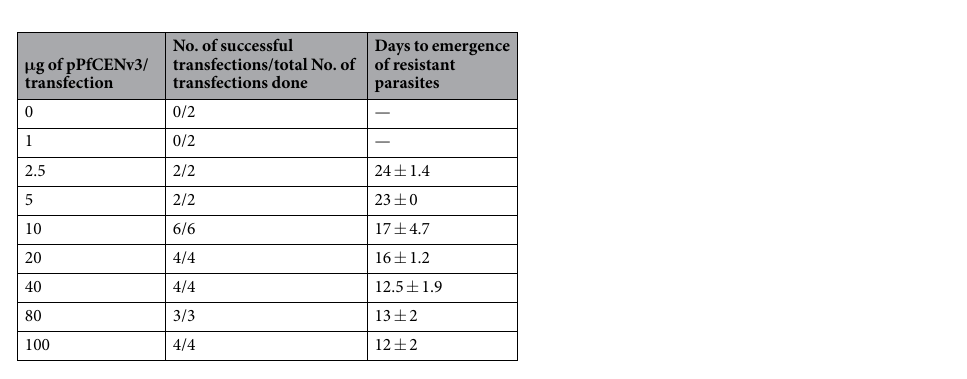
Table 2. Optimization of plasmid DNA amount for transfection of P. falciparum 3D7 by the LyRET method. Each transfection experiment was independently performed. The days to emergence of resistant parasites is mean with SD of the days required for emergence of resistant parasites in successful